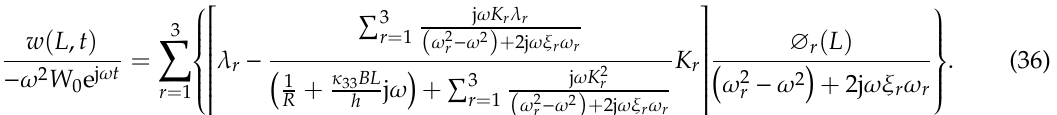
Figure 4. Variation of the voltage output with load resistance under excitations at the short and open circuit resonance frequencies of the first vibration mode ( ℎ = 0.3 μm ).